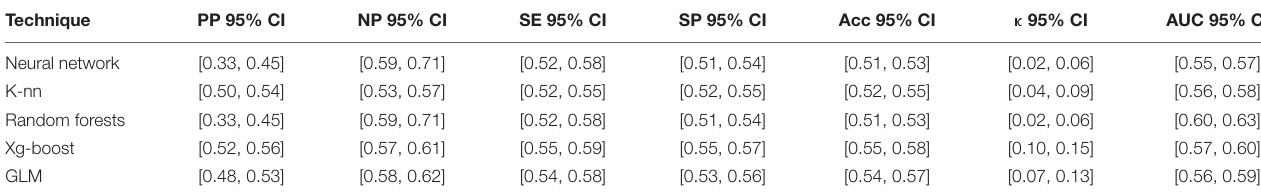
TABLE 6 | Confidence intervals of summary statistics for the predictive ability of the models built with five machine learning techniques in study 2a.